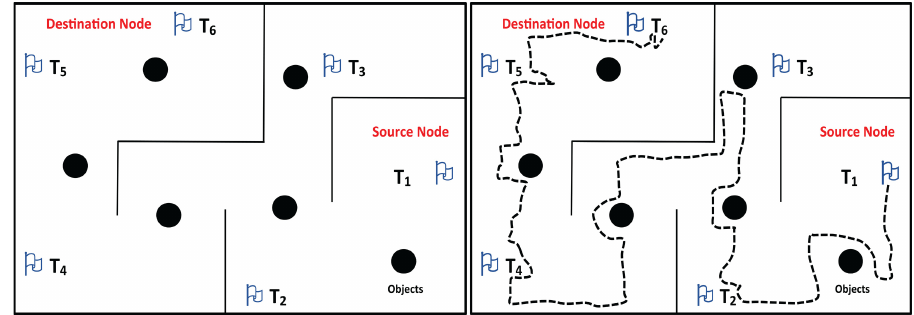
Fig. 8. The shortest path following by computing obstacle avoiding algorithm [right] is simulated in an indoor environment [left] with path and